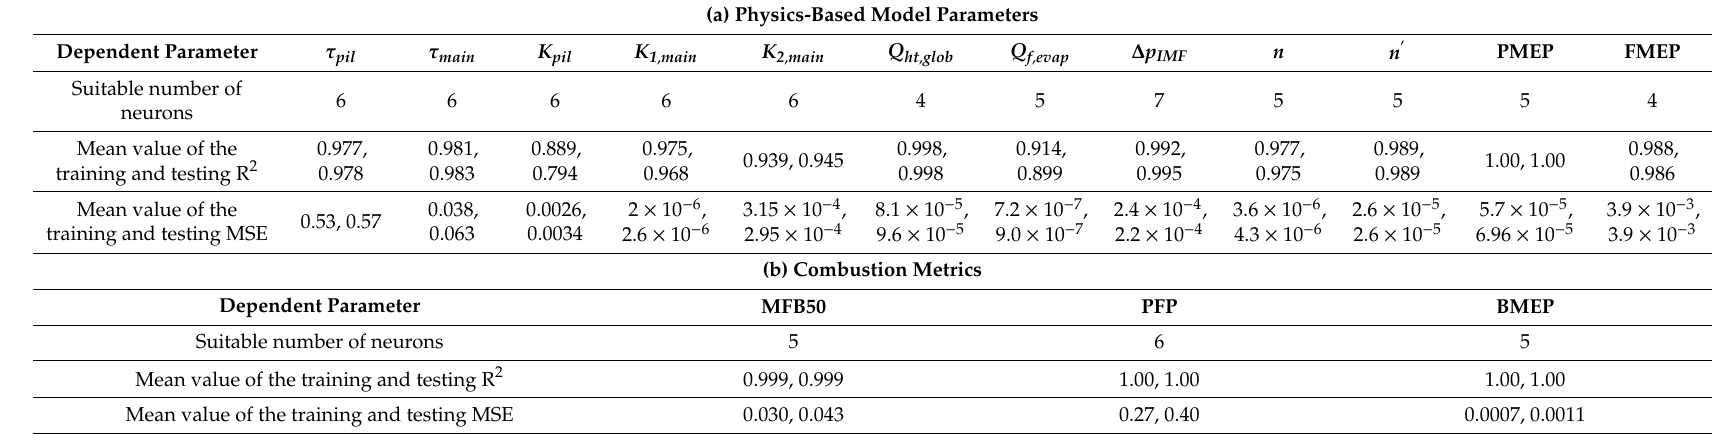
Table 7. The most suitable number of neurons and the corresponding mean values of R 2 and MSE (over 200 training trials) for the ANNs that simulated the parameters of the physics-based model (a) and the combustion metrics